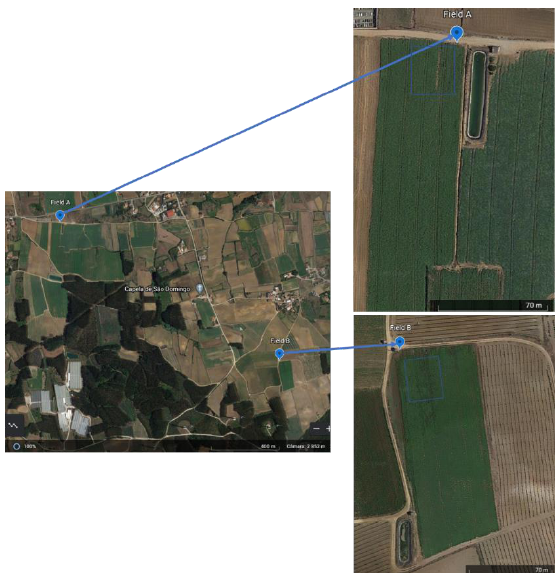
Figure 1. Geographic location of the two fields (Field A and Field B) (images obtained through Google Earth). Indication (in blue) of the limits of soil sample collection in the fields. (Note: when the soil samples were taken, there was no type of plantation in the two fields. The images shown are for geographic location only—they do not correspond to the date of collection of soil